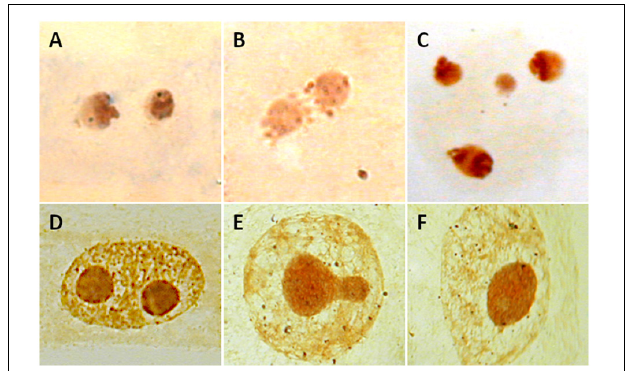
FIGURE 5 | Nucleoli in interphase nuclei of Medicago species (A–C) and Cistus heterophyllus (D–F) after Ag-NOR staining. (A) Two nucleoli are observed in diploid M. marina (2n = 2x = 16). (B) A single nucleoli is observed in M. arborea (2 n = 4x = 32). (C) Four nucleoli are shown in hexaploid M. citrina (2 n = 6x = 48). (D–F) Process of mononucleation (nucleoli fusion) in C.